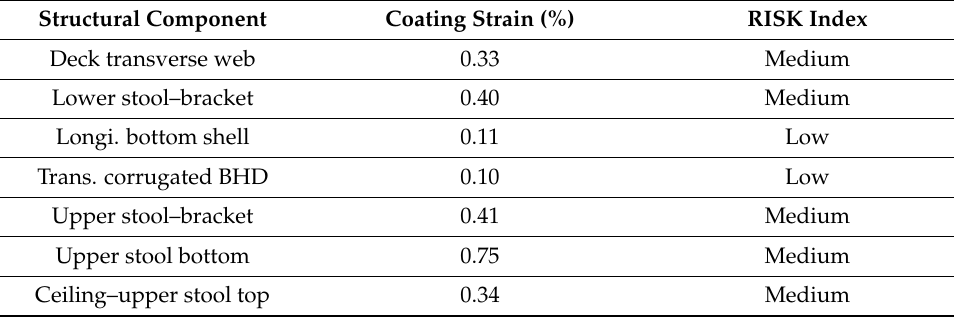
Table 2. Summary of the coating strain and RISK index according to